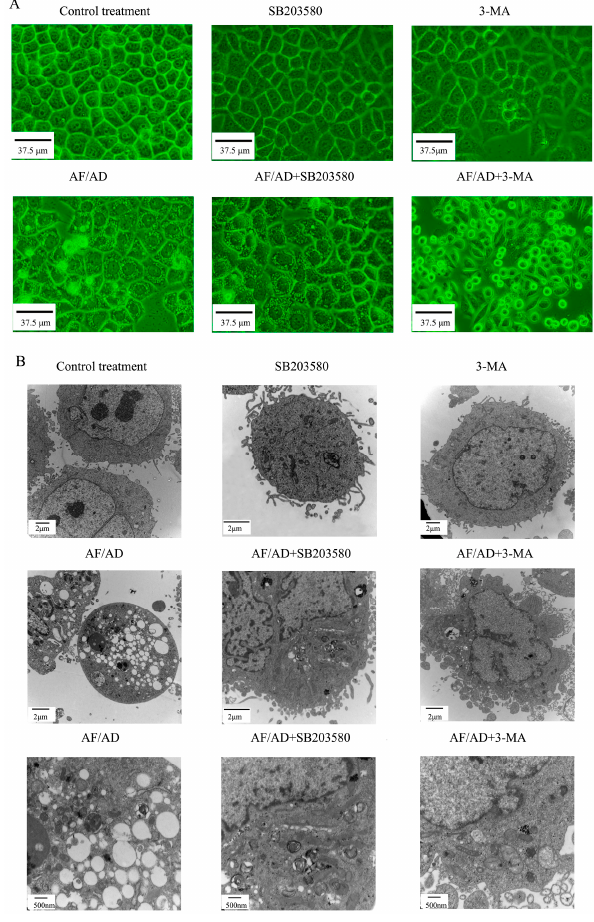
Figure 1. Effect of AF/AD on Bel-7402 cells morphology with or without SB203580 or 3-MA. Bel-7402 cells were pretreated with AF (6 µ M)/AD (20 µ M) in the absence or presence of SB203580 (10 µ M) or 3-MA (5 mM) for 24 h, and then cell morphology was analyzed by inverted microscope ( A ) and transmission electron microscopy ( B ).